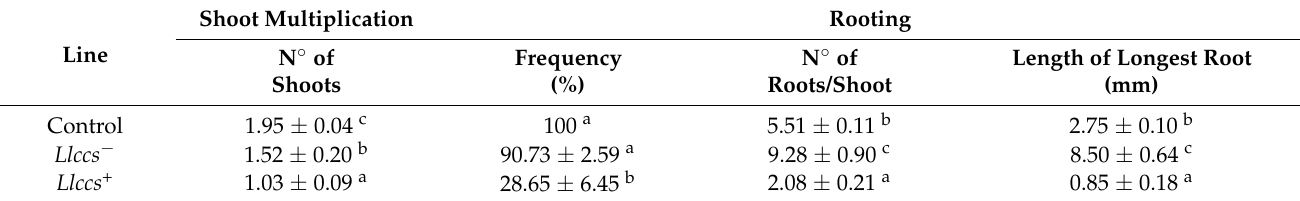
Table 4. Multiplication and rooting of control, Llccs − and Llccs + transgenic V. cornuta shoots in culture in vitro. Shoot Multiplication Line